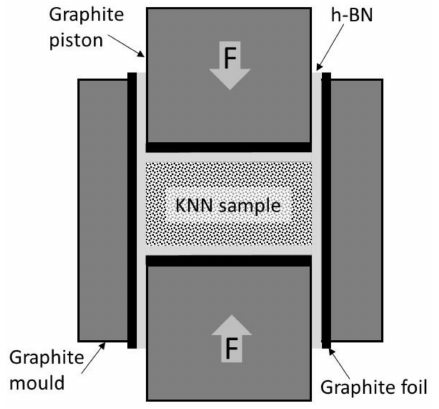
Figure 1. The hot-press graphite mold protected by graphite foil and sprayed h-BN